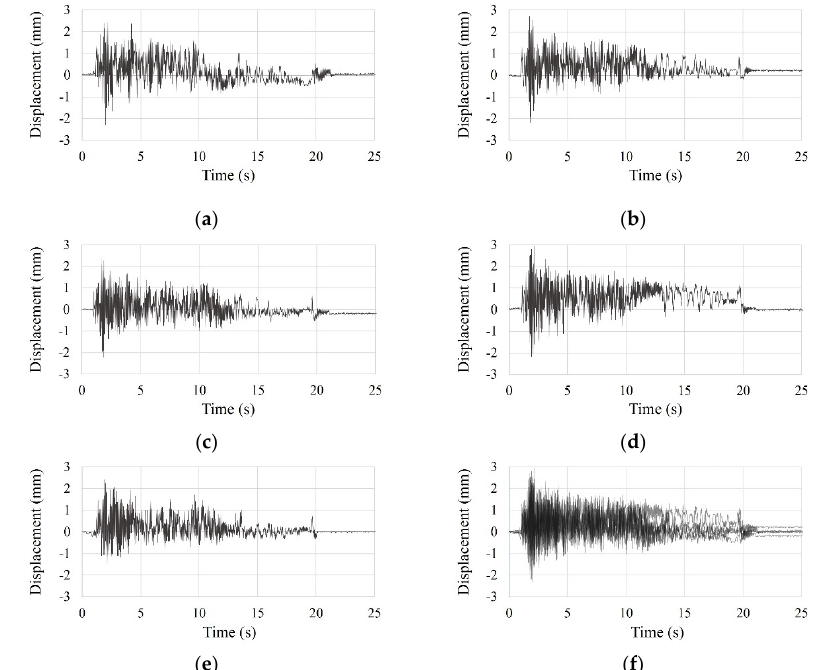
tro earthquake vibration are shown in Figures 13 and 14.